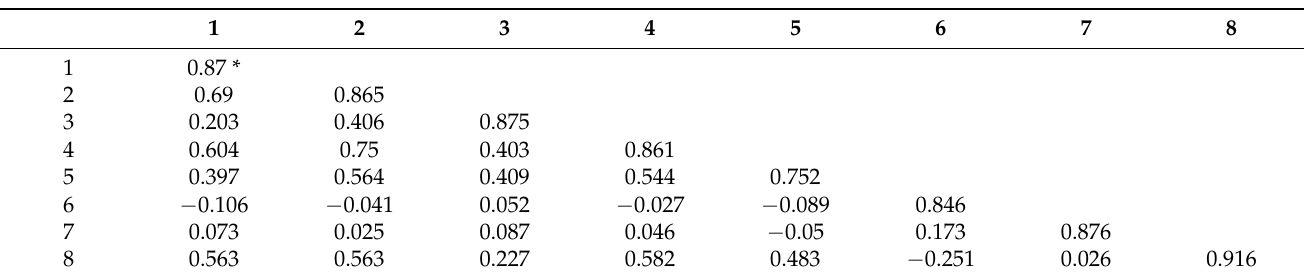
Table 3. Results of discriminant validity analysis.